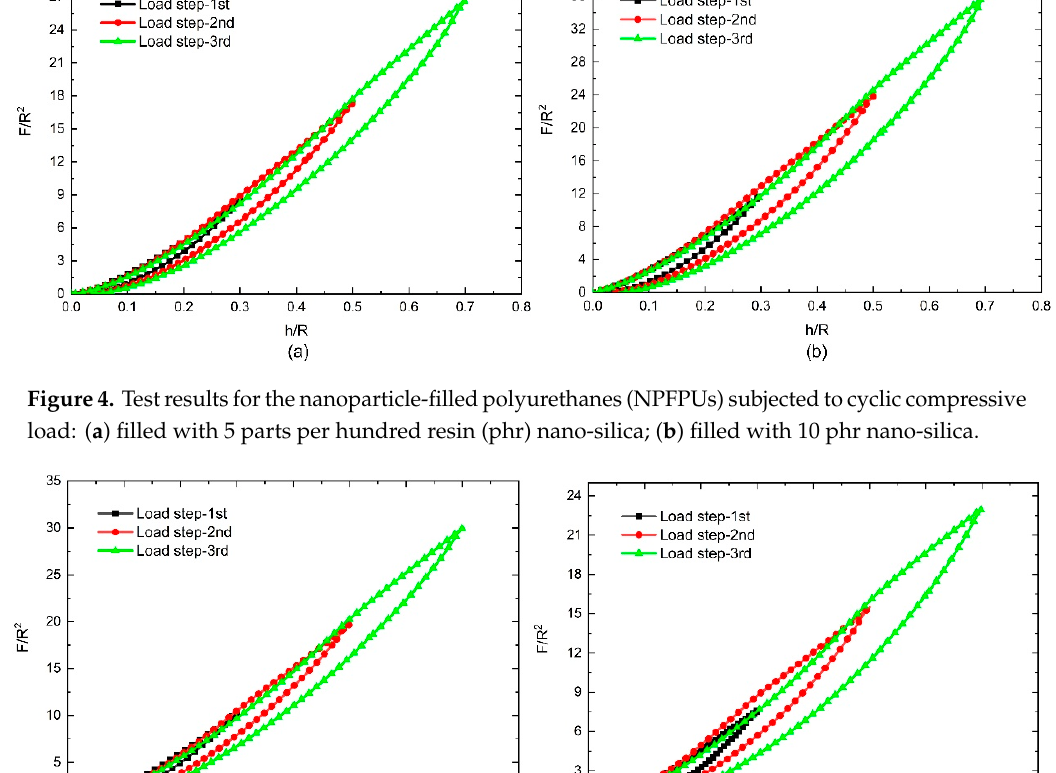
Figure 6. Integrals of the hysteresis loop areas from the compression tests. As shown in Figure 6, integration of the hysteresis loop areas revealed that the energy dissipation effect varied greatly among the NPFPUs. The dissipated energy indicated by the hysteresis loop area can be calculated using the following equation [38], ( )